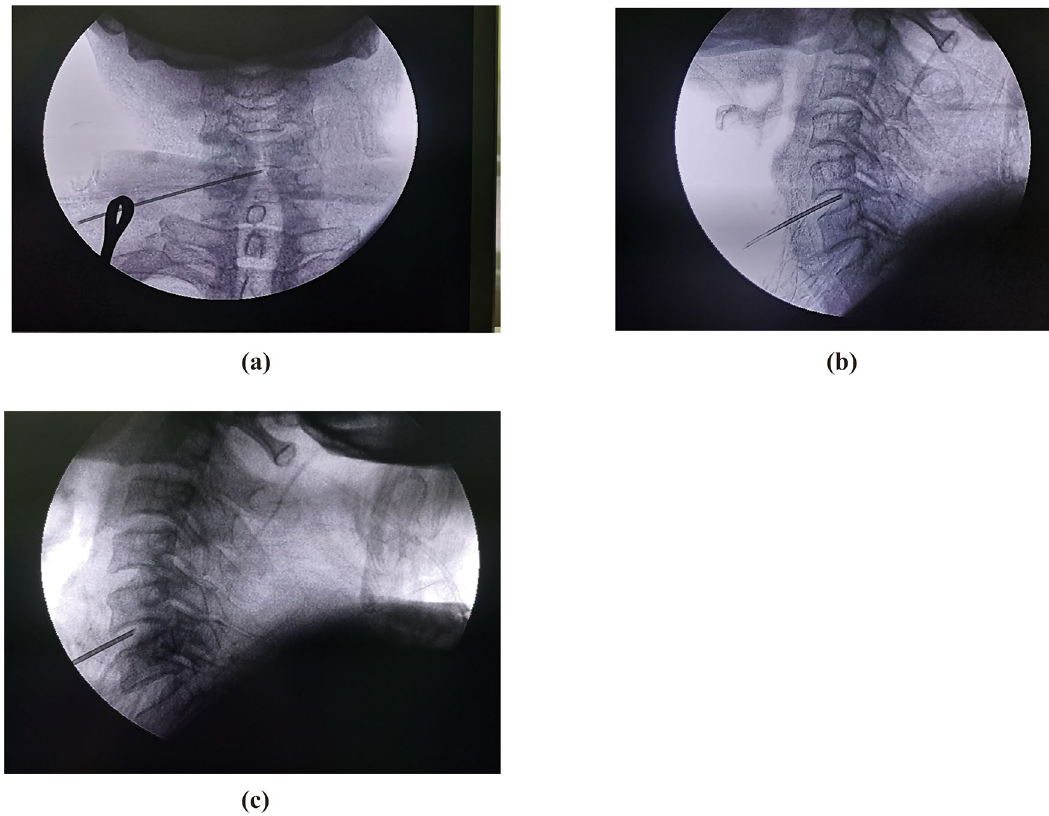
Figure 5. Fluoroscopic imaging of cannula position. ( a ) Anterior–posterior and ( b ) lateral view of cannulation at initial surgical site. ( c ) The second site of laser decompression is located in the middle of intervertebral disc, confirmed by the lateral view of